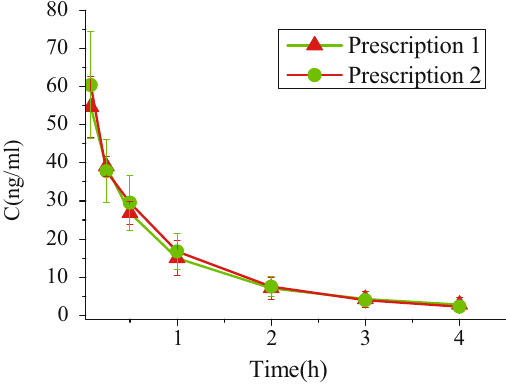
Figure 7: Comparison of sustained release between the two prescriptions.